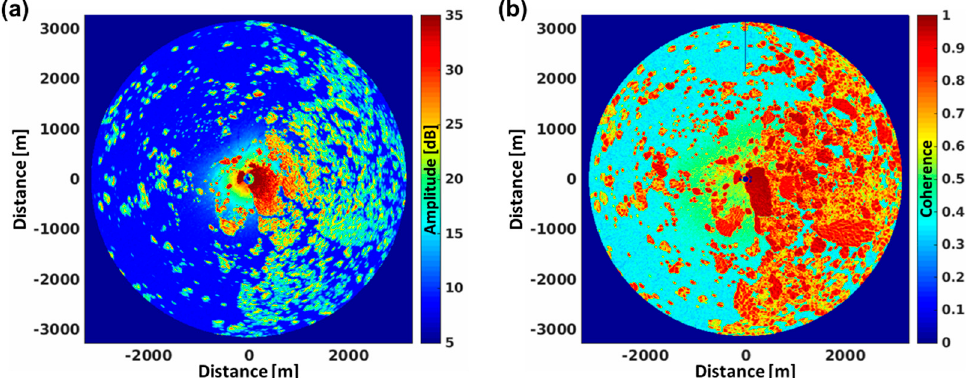
Figure 10. Marine radar measurements of sea ice at VV-polarization in the Fram Strait, acquired from the RV Lance on 3 September 2015 at 14:00 UTC. At the time of acquisition, the vessel was moored to the huge ice float to the east. The amplitude ( a ) and coherence ( b ) were retrieved from 50 rotations (100